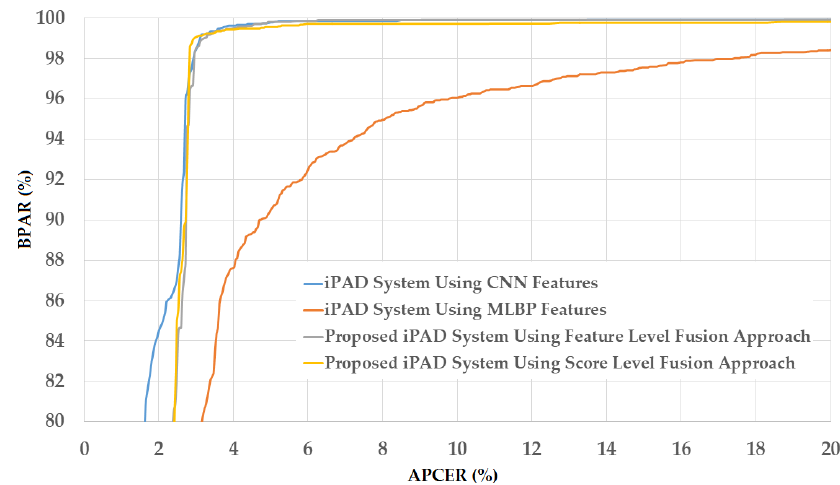
Figure 17. DET curves of iPAD methods based on use of CNN, MLBP, or hybrid image features (feature level fusion and score level fusion approach) using entire ND2015 dataset.